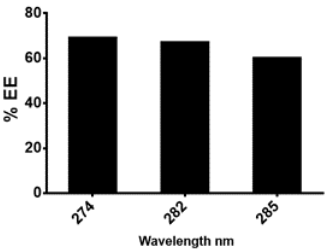
Figure 4. Percentage of the age encapsulation efficiencies calculated at different wavelength.